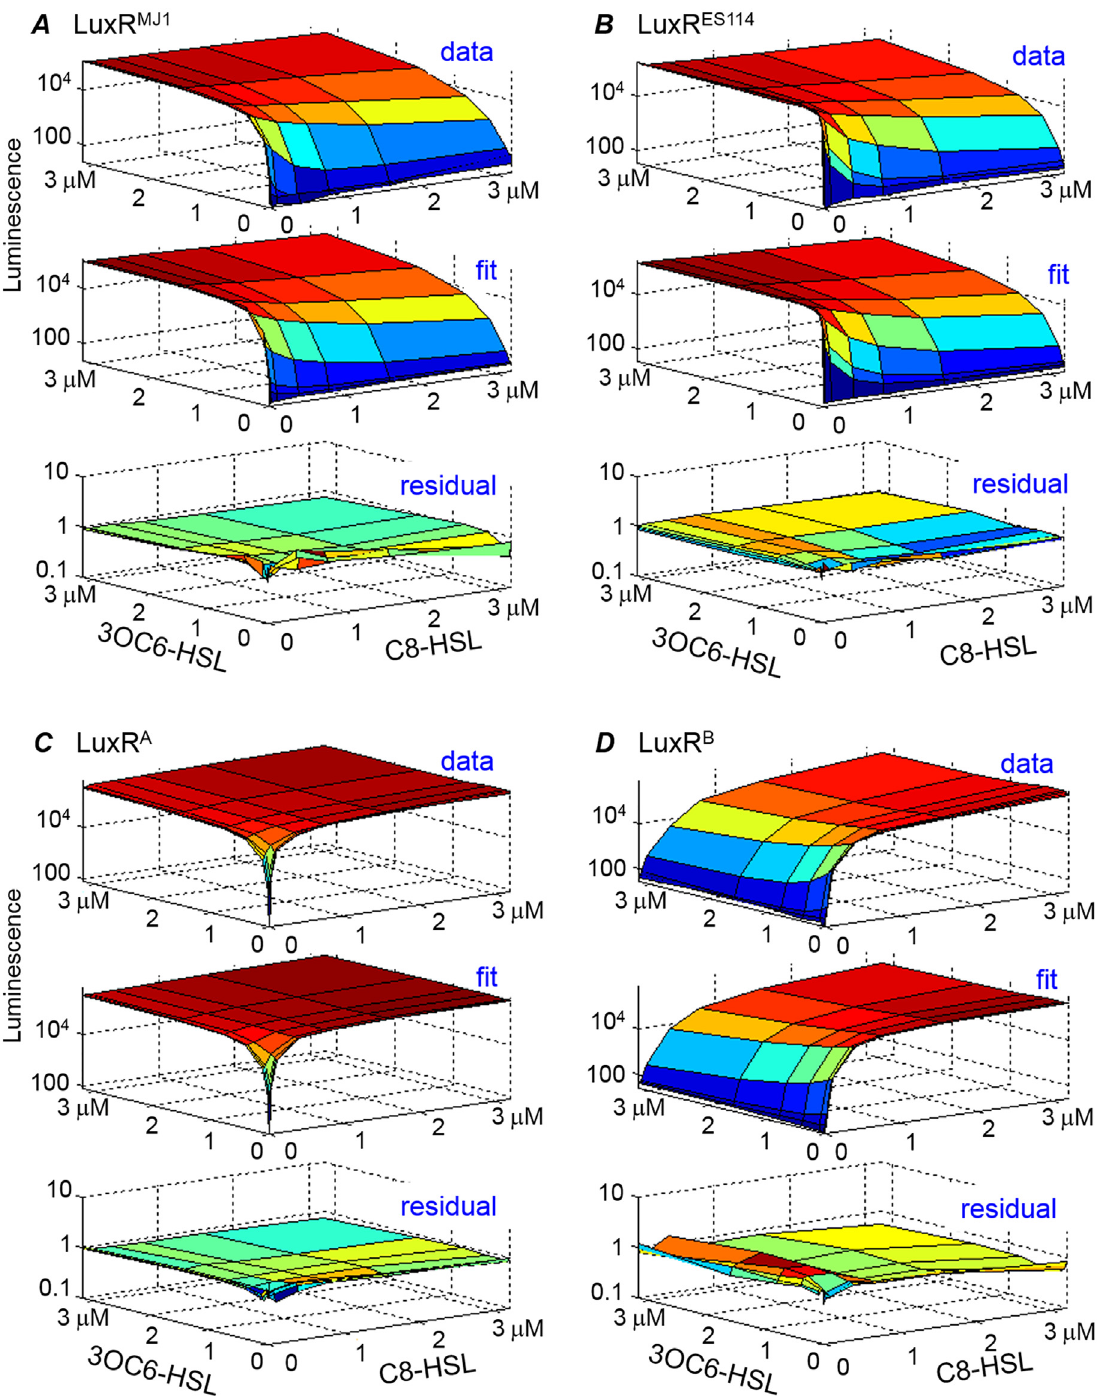
Fig 3. Comparing data and fit for Δ ainRS mutants of the four LuxR variants. Each of panels ( A )-( D ) shows a representative luminescence dataset and fit for one of the Δ ainRS strains, where luminescence is measured as a function of C8-HSL and 3OC6-HSL concentration. The luminescence (vertical) axis for data is shown on a logarithmic scale. The lower figure of each group shows the residual on a logarithmic scale, i . e . the ratio data/fit is shown on a logarithmic scale. The set of parameter values obtained in 150 fits of 3 datasets for each LuxR are shown in Fig 6 and summarized in Table 2.